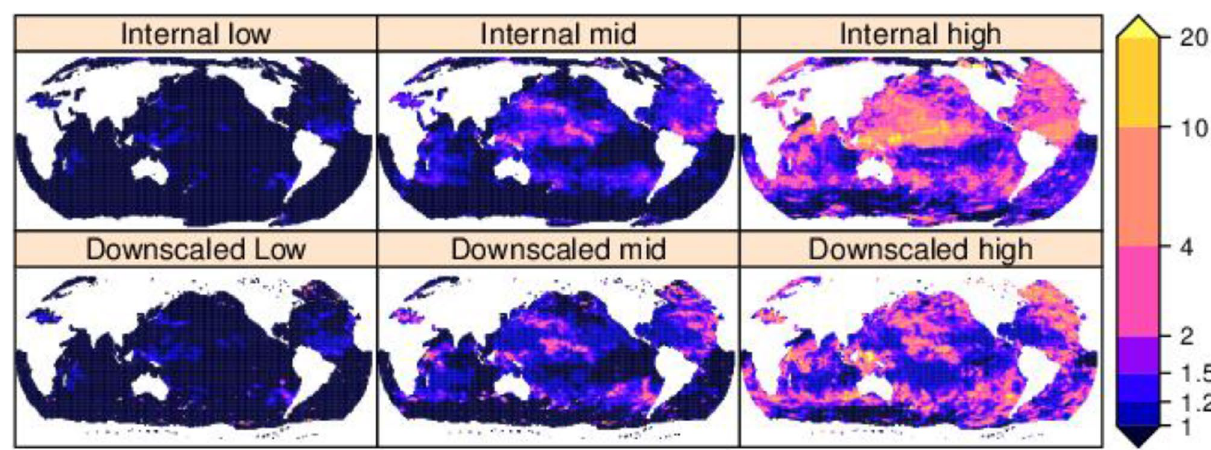
Figure 6. Same as Fig. 5 but for a reduction of the baseline 1% AEP over a period of 100 years. created using the R statistical software version 4.0.2 22